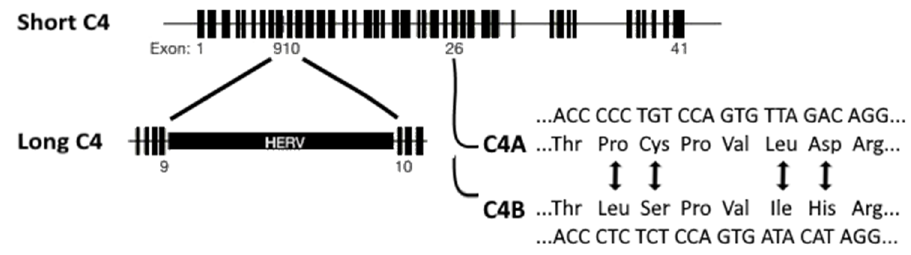
Figure 2. Isotypes of human C4 gene located on chromosome 6. C4A and C4B can be distinguished by amino acid differences. Long genomic forms of either C4A or C4B include an HERV insertion in intron 9. Image adapted from Sekar et al. [15].